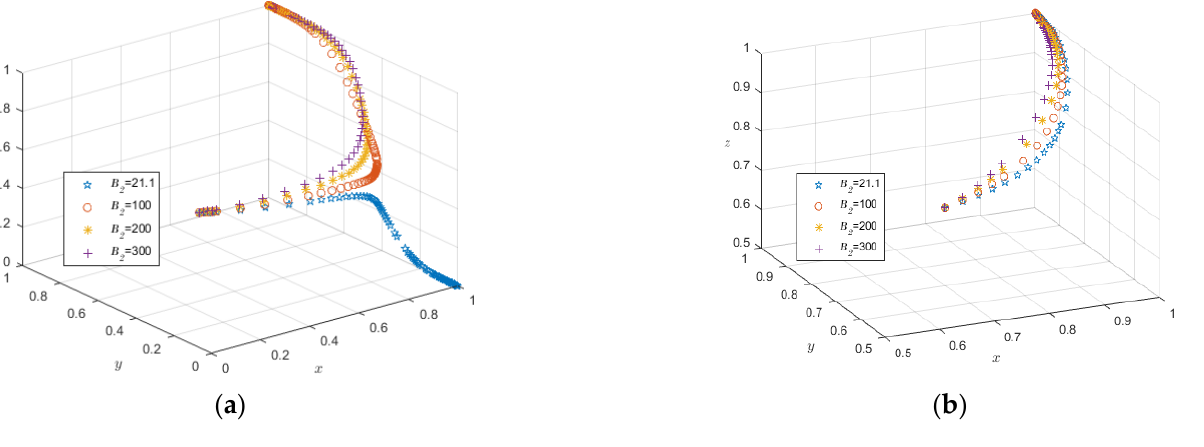
Figure 6. The evolution path under different farmers’ fines: ( a ) evolution path of System A with (x 0 , y 0 , z 0 ) = (0.32, 0.48, 0.4); ( b ) evolution path of System B with (x 1 , y 1 , z 1 ) = (0.7, 0.7, 0.7). In Figure 7, when B 2 is increased to 100, farmers have a “hesitation” time and do not